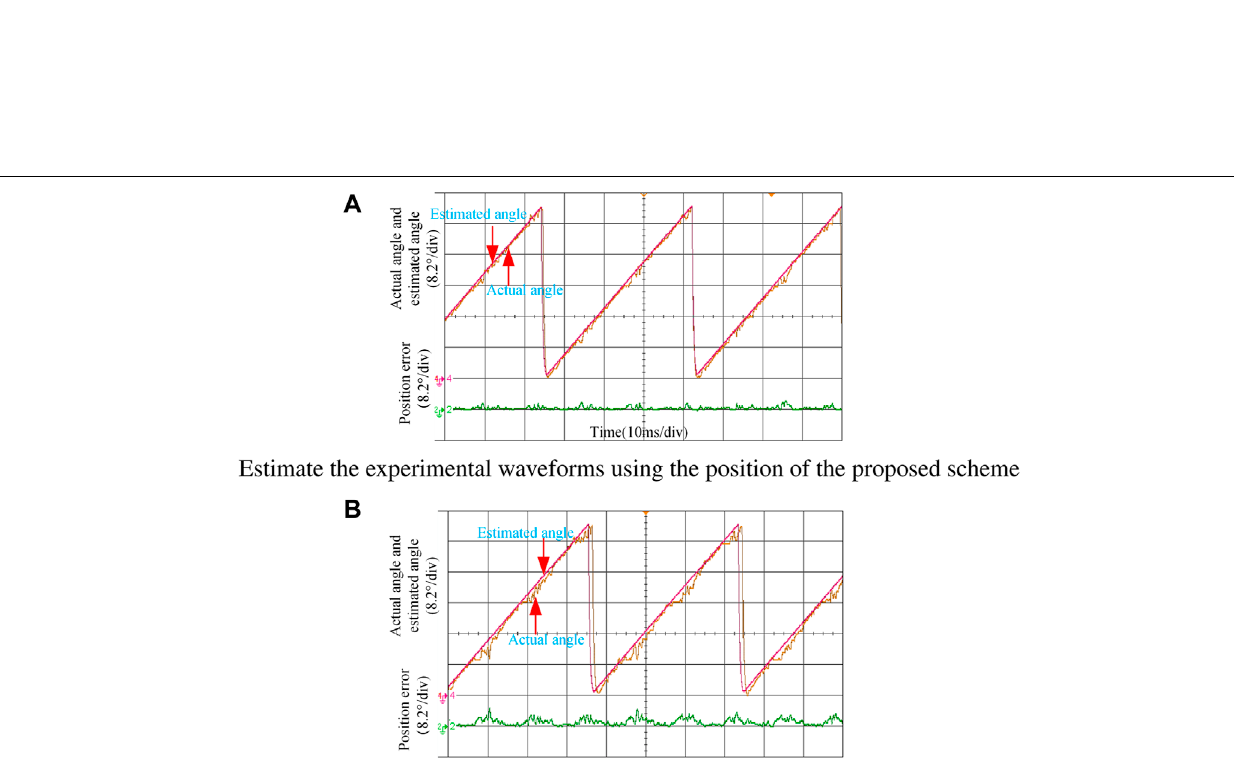
Frontiers in Energy Research |